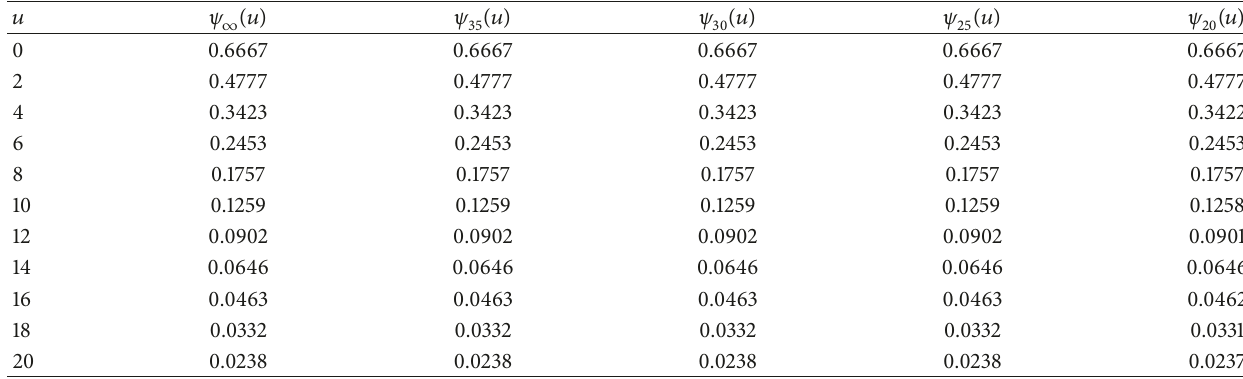
Table 1: Ruin probabilities for XL reins. in CLM: Exp (0.5) claims ( 𝜆 = 2, 𝑐 = 6 ).